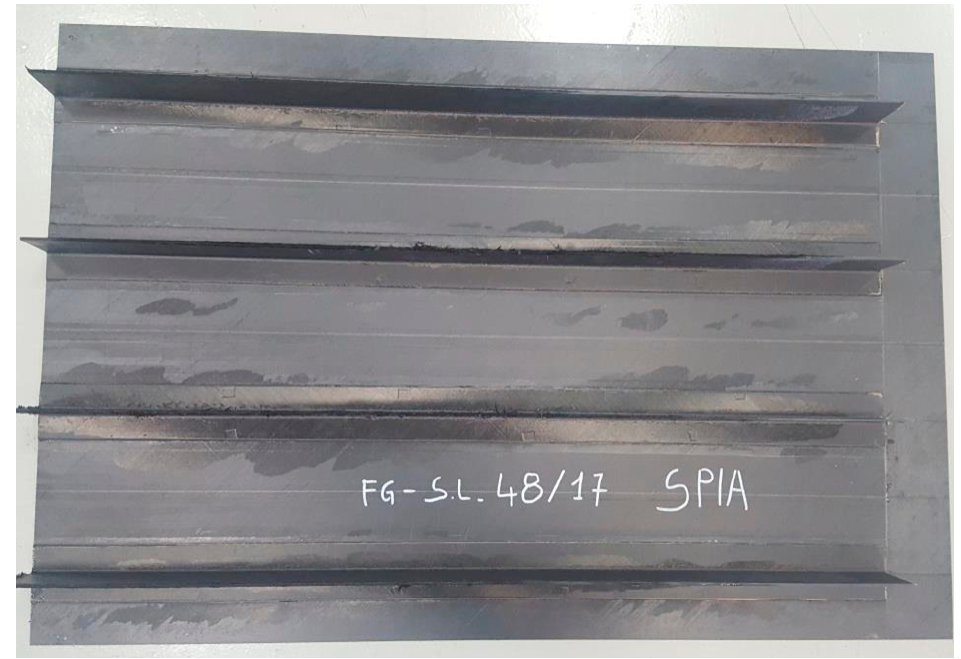
Figure 10. The simulated times for the resin to reach the outlet at the top of the stringers is between 719 and 724 s, in very good agreement with the experimental data obtained from the optical fibers positioned at the same position on top of the stringers, as reported in Table 5. It should be underlined that an error occurred in the measurement of the FBG sensor located on the 4th stringer (FBG4). For this reason, the relative value is not reported in Table 5.